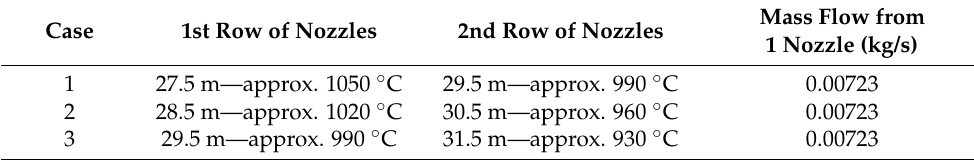
Table 9. The cases of urea solution injections.